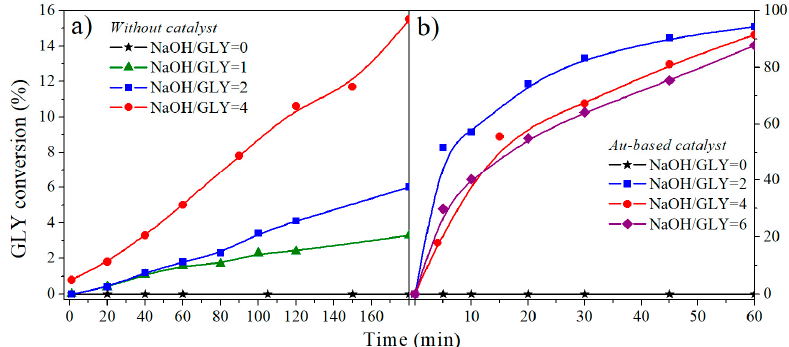
Figure 7. Conversion/t-profile of the GLY oxidation without catalyst ( a ) and with supported Au catalyst ( b ) by using different NaOH/GLY ratios. Reaction conditions: C 0 GLY = 0.3 mol/L, pO 2 = 5 bar, T = 60 °C, GLY/Au = ∞ ( a ), and 3500 mol/mol ( b ), stirring speed = 1500 rpm.